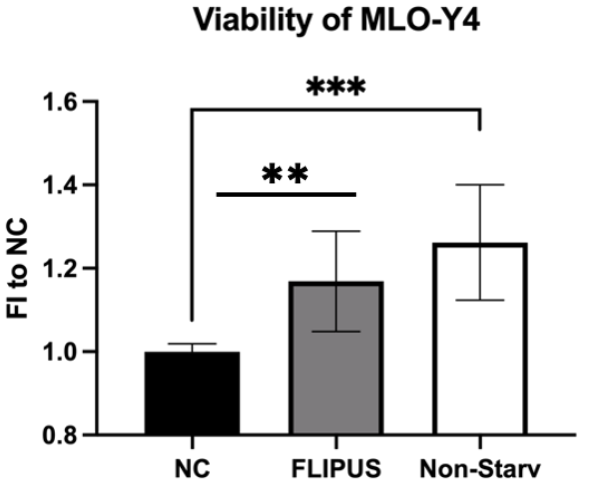
Figure 2. FLIPUS enhances the metabolic activity of starved MLO-Y4 osteocytes, measured by WST-8 assay. FI to NC stands for fold induction over negative control, samples which did not receive stimulation with ultrasound. Each data point was the result of N = 3 and n = 3, where N and n are biological trials and technical replicates, respectively. ** and *** represent p ≤ 0.01 and p ≤ 0.001, respectively.